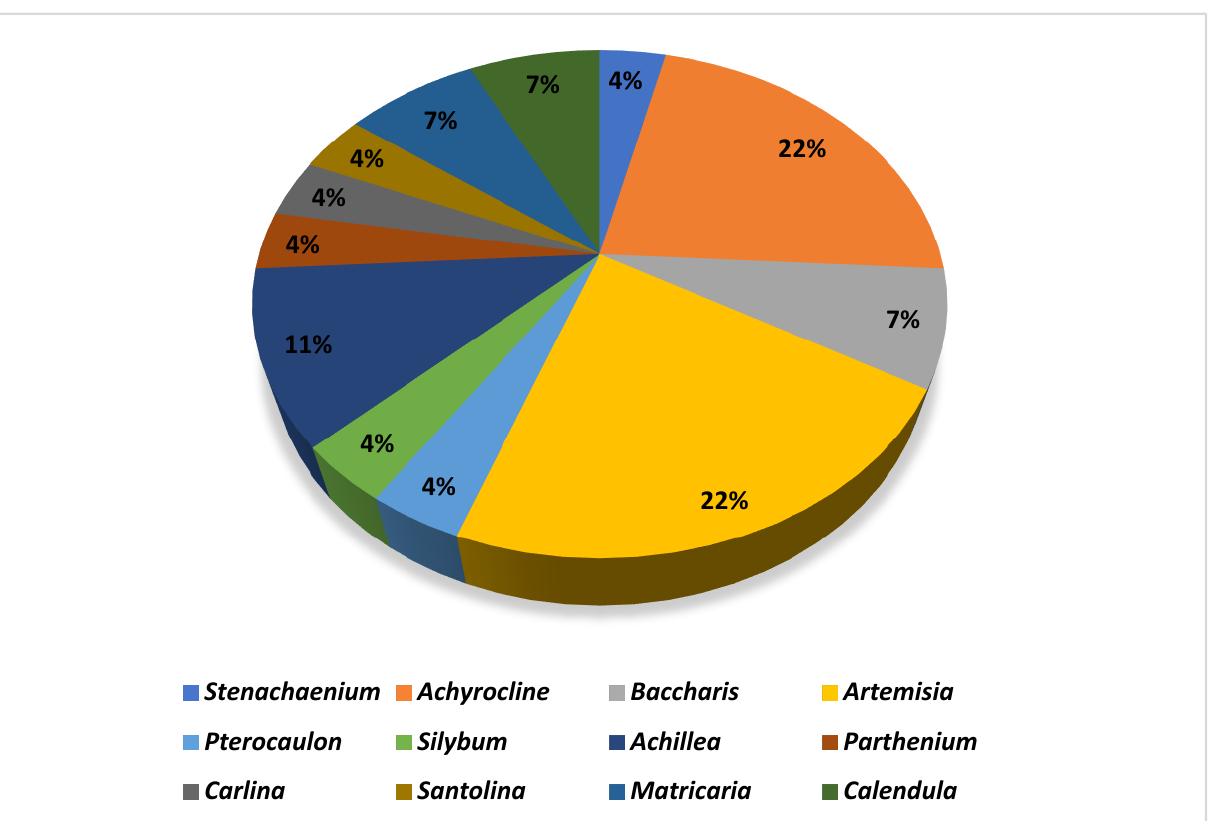
Figure 2. Plant genera most used in the development of nanoformulations.